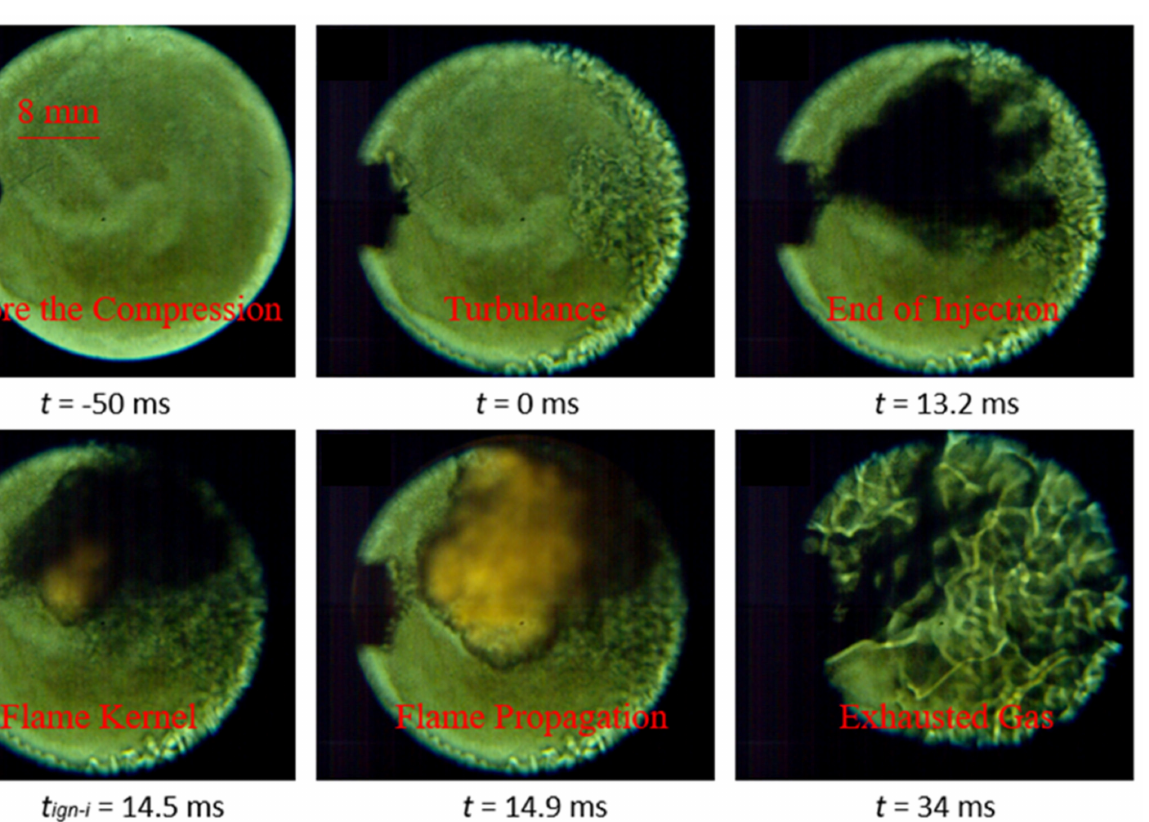
Figure 4. Combustion visualization of RP-3 kerosene spray generated by a multi-orifice